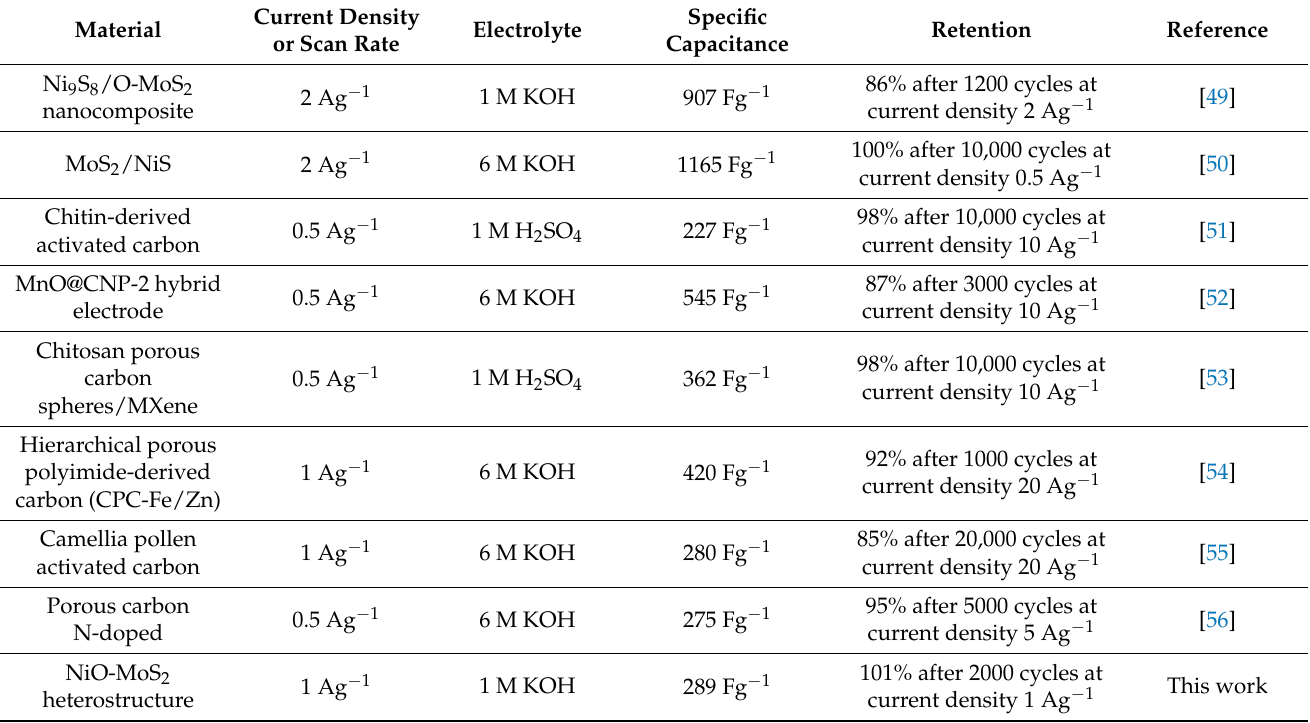
and NM10; Figure S2: GCD specific capacitance for different energy density; Figure S3: TGA of N, M, NM3 and NM10; Figure S4: Photograph of lab scale supercapacitor device; Table S1: